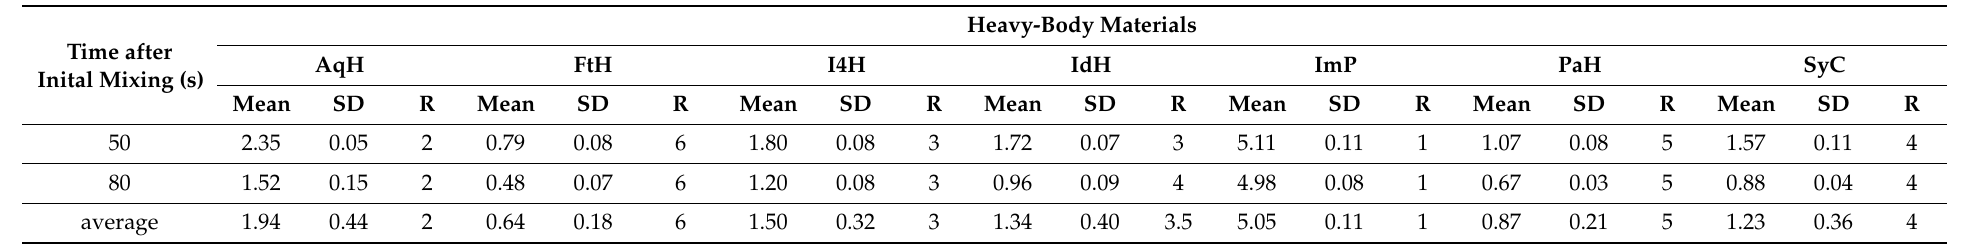
Table 3. Mean and SD of fin heights were derived after testing heavy-body materials and their ranks (R). Tests had a statistical difference within each time group.